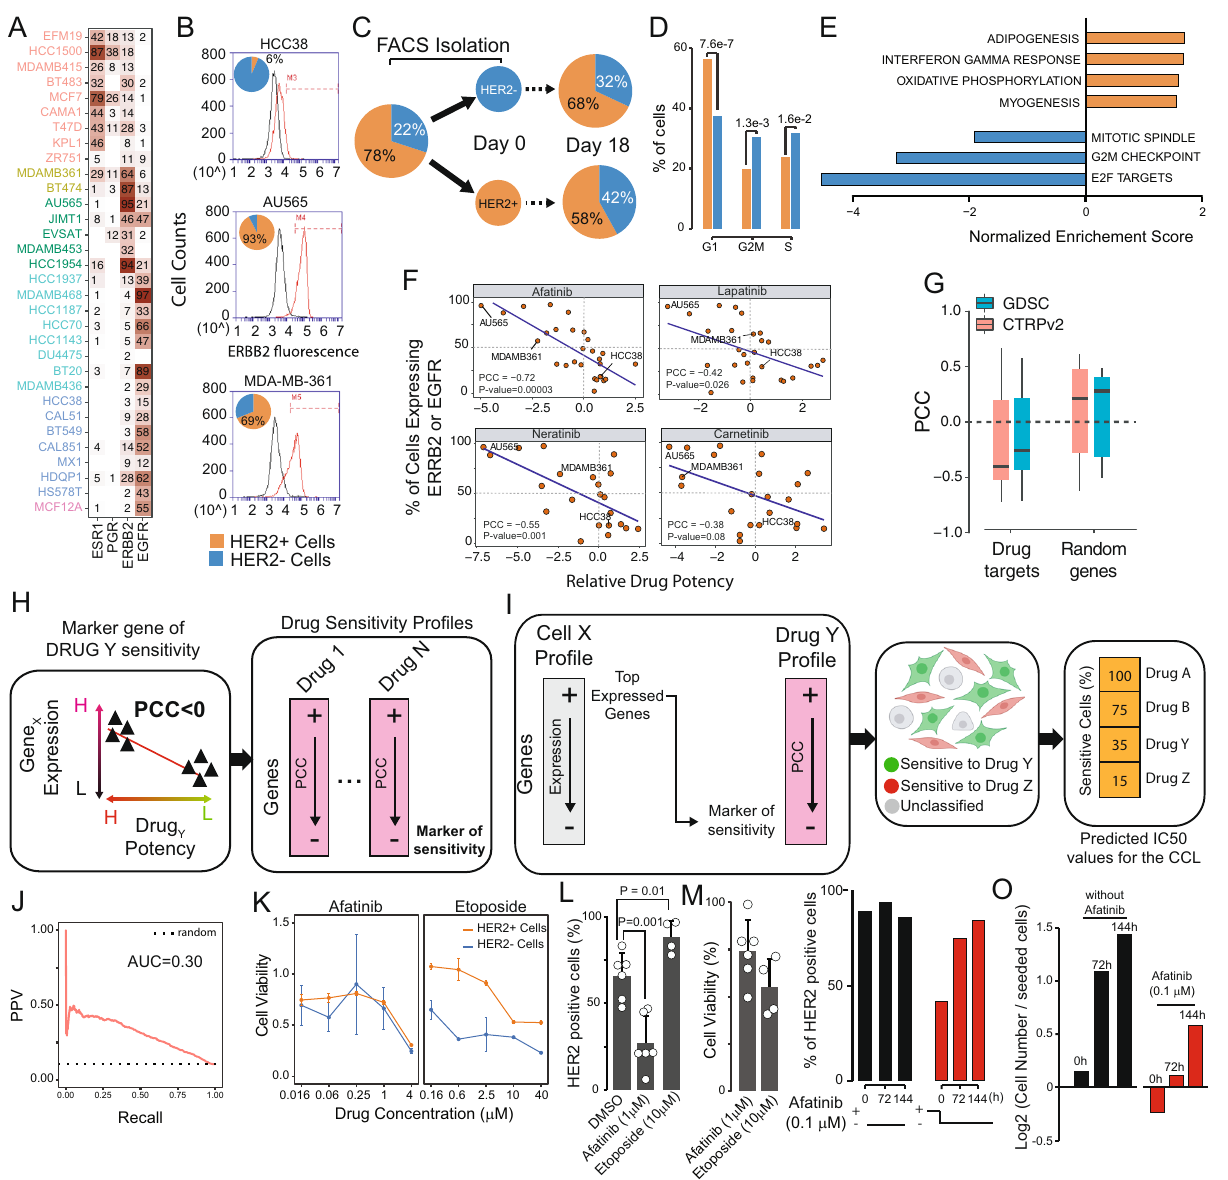
Fig. 3 Transcriptional heterogeneity in breast cancer cell lines and its impact on drug response. A Percentage of cells expressing the indicated genes in each of the 32 cell lines. B Fluorescence cytometry of HCC38, MDA-MB-361 and AU565 cell lines stained with a fl uorescent antibody against HER2. C Expression of HER2 protein in MDA-MB-361 cells is dynamic and re-established in less than 3 weeks. D Cell cycle phase for the HER2 + and HER2 − subpopulations of MDA-MB-361 cells. p -value refers to the Fisher ’ s exact test. E Enriched pathways (GSEA, FDR < 10%) across differentially expressed genes between the HER2 + (orange) and HER2 − (blue) MDA-MB-361 cells. F Gene expression versus drug potency for four anti-HER2 drugs. Each dot corresponds to a cell line with percentage of cells expressing ERBB2 or EGFR [ y -axis] versus the experimental drug potency 8 as Area Under the Curve (AUC) [ x -axis]. PCC (Pearson correlation coef fi cient) and its p -value are also shown. G PCC values computed as in F for 66 drugs for which the cognate drug targets is known. The PCC distribution when choosing a random gene is also shown. Boxplots containing PCC distribution between a random gene and drug n = 1000, while n = 66 for boxplot containing PCC distribution between a drug and its cognate target gene. H Bioinformatics pipeline for the identi fi cation of drug sensitivity biomarkers for 450 drugs. I The top 250 most expressed genes in a single cell are used as input for a GSEA against the ranked list of genes correlated with drug potency for each one of the 450 drugs to predict its drug sensitivity. J Performance of DREEP in predicting drug sensitivity of 32 cell lines in the atlas to 450 drugs in terms of PPV (Positive Predicted Value) versus Recall. K Dose-response curve in terms of cell viability following treatment with either afatinib or etoposide at the indicated concentrations on sorted MDA-MB-361 cells (triplicate experiment). L Percentage of HER2 + cells in MDA-MB-361 after 72 h treatment with either afatinib or etoposide. (two-sided t -test), and M cell viability. N Percentage of HER2 + cells in MDA-MB-361 cell line at the indicated time-points either following 48 h of afatinib pre-treatment (red bars) or without any afatinib pre-treatment (black bars) and O the relative number of cells rescaled for the number of cells at the beginning of the experiment. Source data are provided in a Source data fi le. For K , L n =